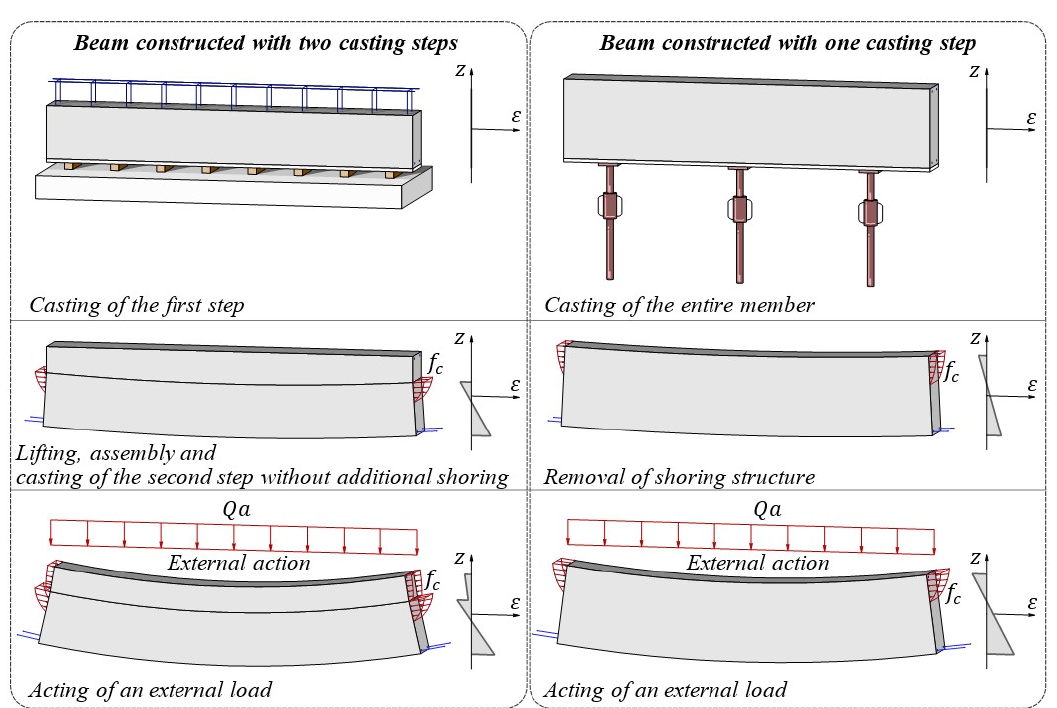
Figure 1. Comparison between construction